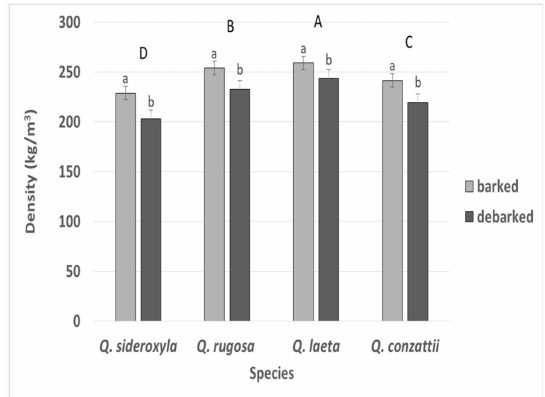
Figure 2. Sawdust bulk density of four barked and debarked oak species. (bars with different letters correspond to statistically different densities; p < 0.05).